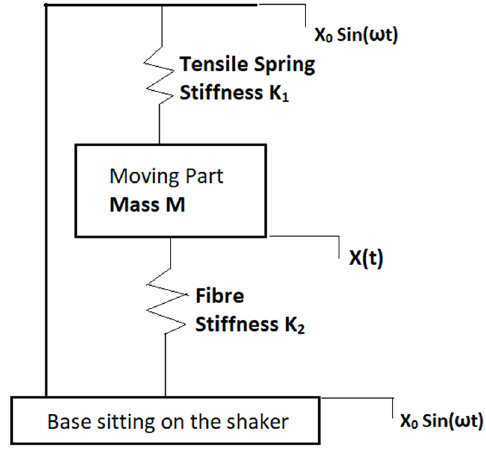
Figure 2. Dynamic configuration of the fibre test rig.